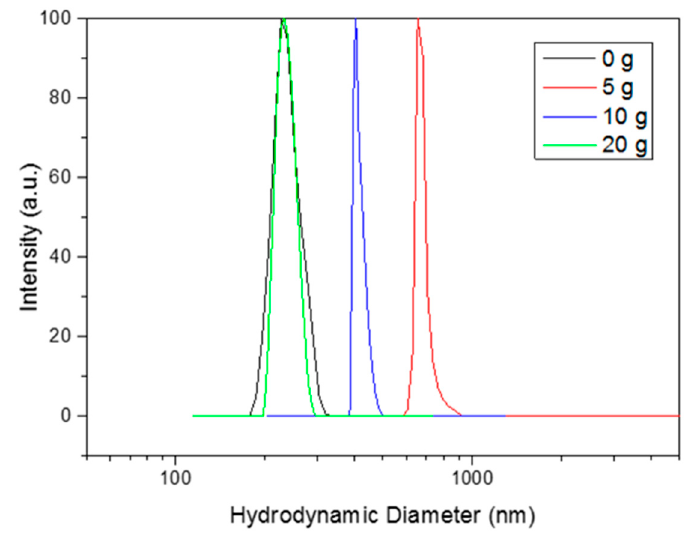
Figure 4. Hydrodynamic diameters (mode weighted in number of particles) of the synthesized materials measured by dynamic light scattering (DLS).